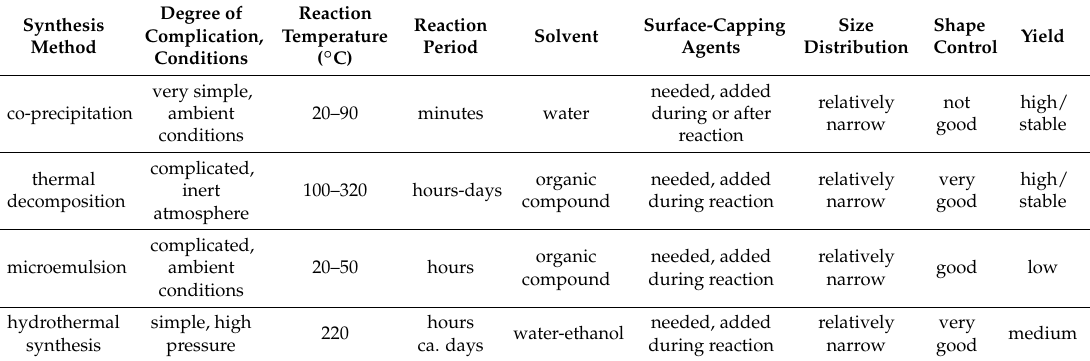
Table 1. A summary comparison of the synthesis methods [33].